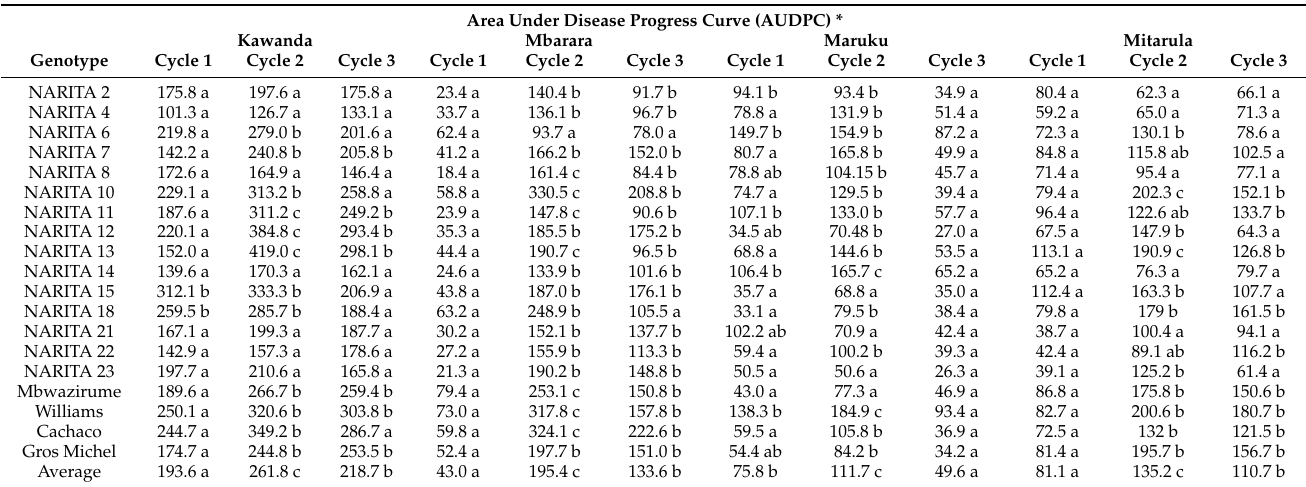
Table 3. Mean black Sigatoka severity (AUDPC) of Matooke hybrids (NARITAs) and banana varieties at each of the four locations in Uganda and Tanzania between 2016 and 2018. Means were compared between cycles at each test location.